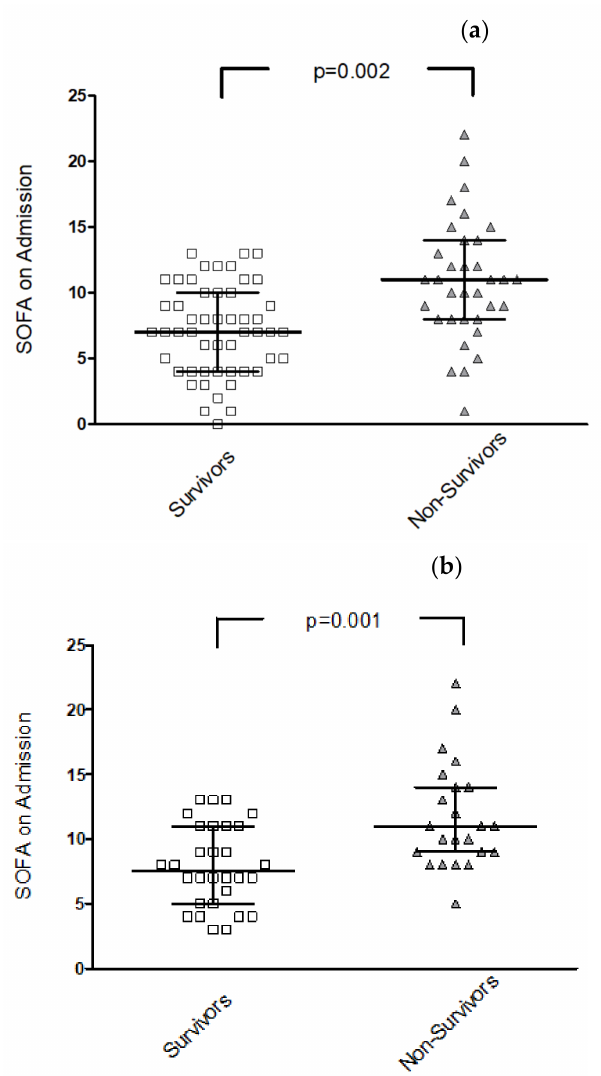
Figure 3. ( a ) SOFA score for all included patients. Left: survivors (squares), right: non-survivors (triangles). Lines show median, bars show interquartile ranges. ( b ). SOFA score for patients with ARDS Type 2 or 3 (moderate or severe, oxygenation index < 200). Left: survivors, right: non-survivors.